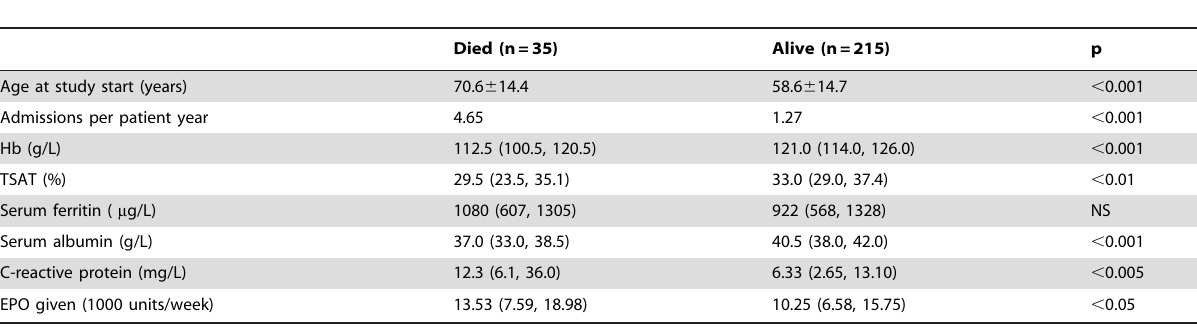
Table 1. Selected data on patients in the study unit who died and who were alive at the end of the